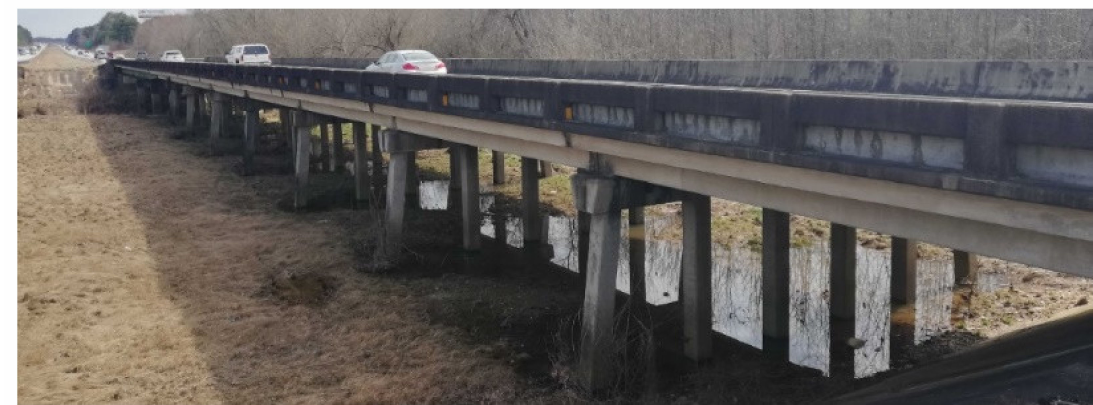
Figure 2. Side view of the bridge.